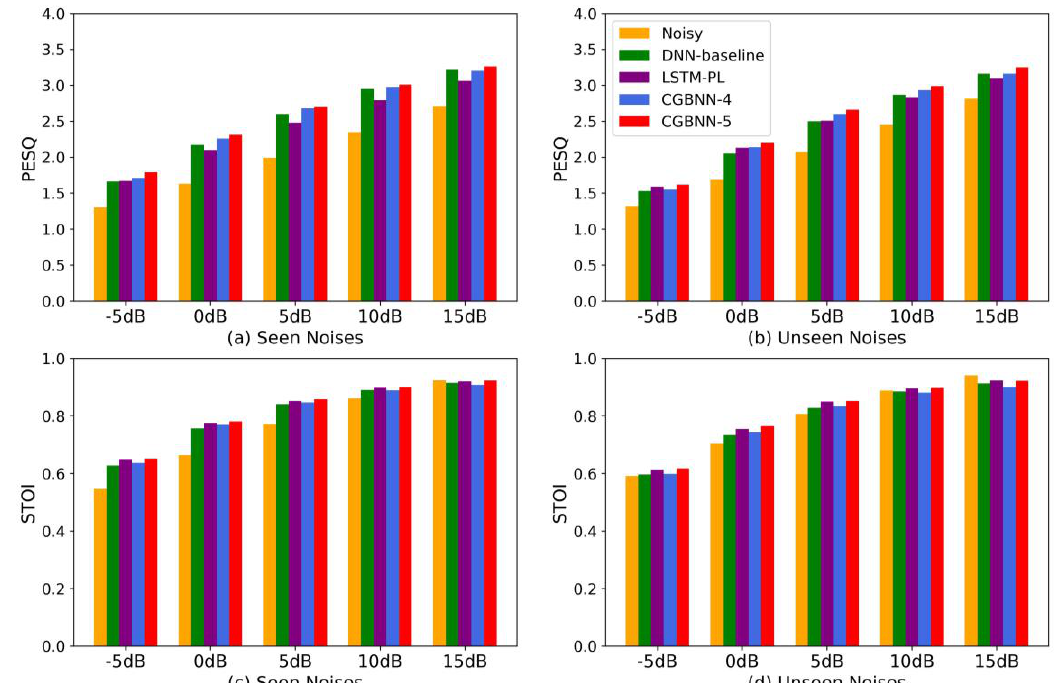
Figure 2. Averaged perceptual evaluation of speech quality (PESQ) and short-time objective intelligibility (STOI) results obtained for noisy and deep neural network (DNN) enhanced speech in seen and unseen noisy environments. ( a ) PESQ in seen noises; ( b ) PESQ in unseen noises; ( c ) STOI in seen noises; ( d ) STOI in unseen noises.